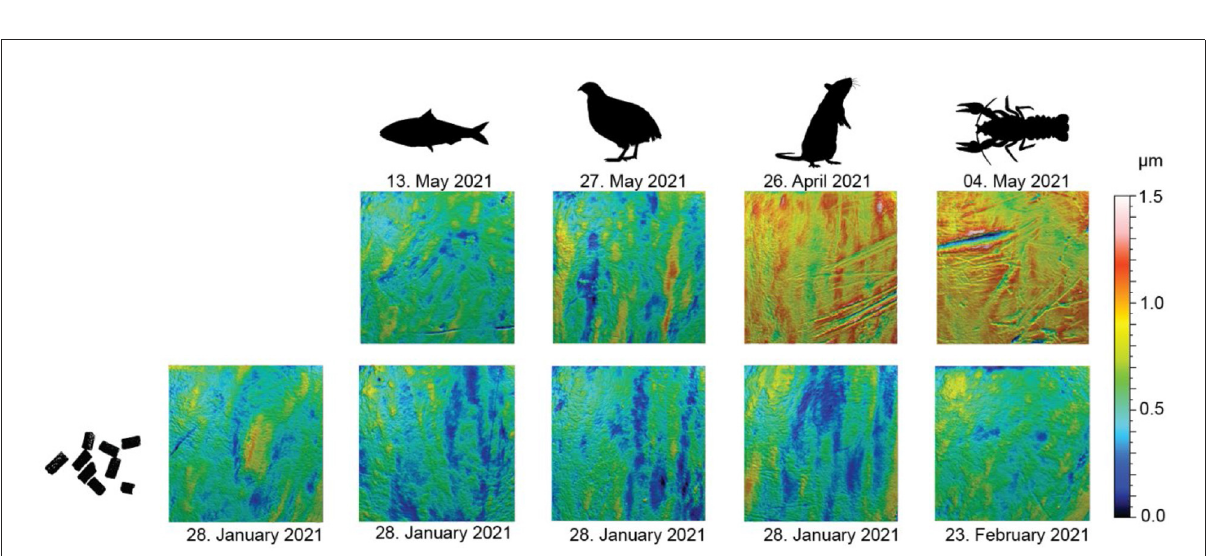
FIGURE2 Scale-limited, filtered, 3D photosimulations of enamel surface textures for each diet. All surfaces are to the same scale. Scan size: 100 × 100 µ m. The upper row shows a diet-related surface from late April/mid-May ( ∼ 3 months into the first phase of the feeding experiment). The lower row shows a surface from a tooth of the same individual as in the corresponding upper row but collected immediately before the start of the feeding experiment (while still feeding on